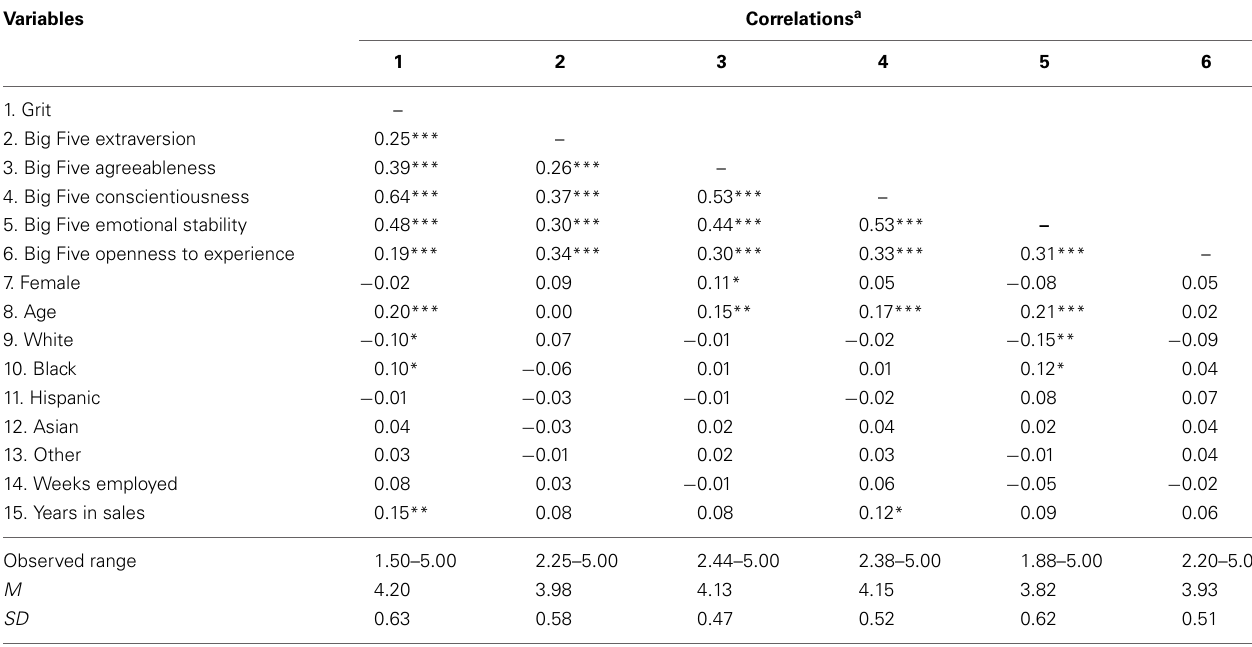
Table 2A | Summary statistics and intercorrelations for sales employees (Study 2). Variables